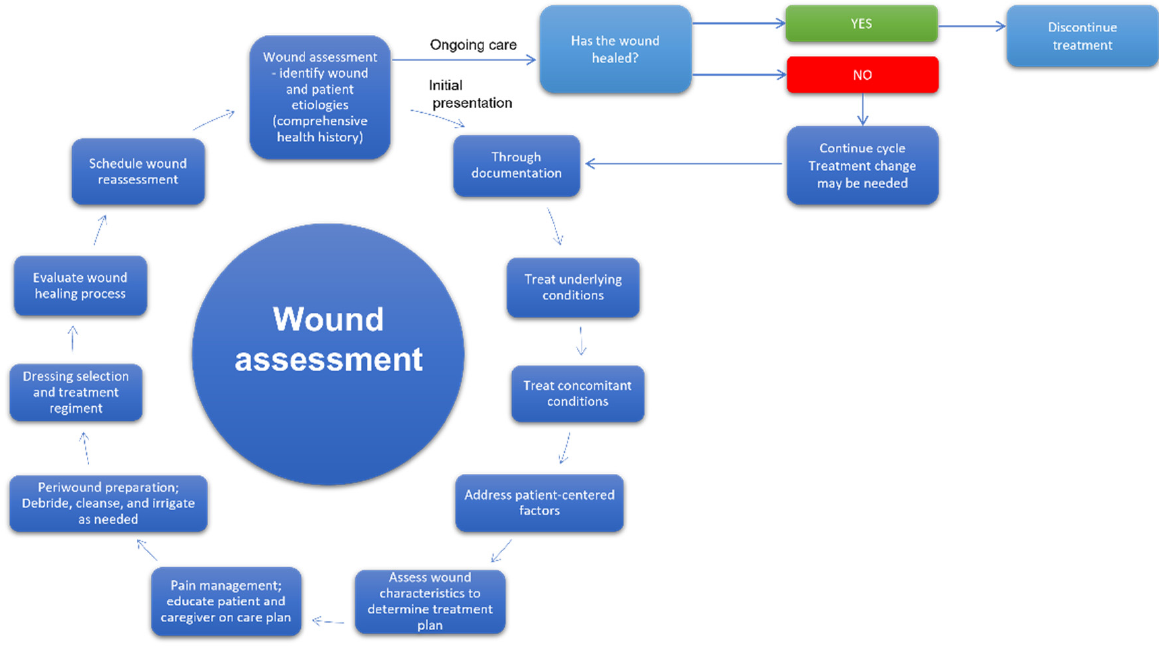
Figure 4. The cycle of wound assessment and decision on procedures [53,58].